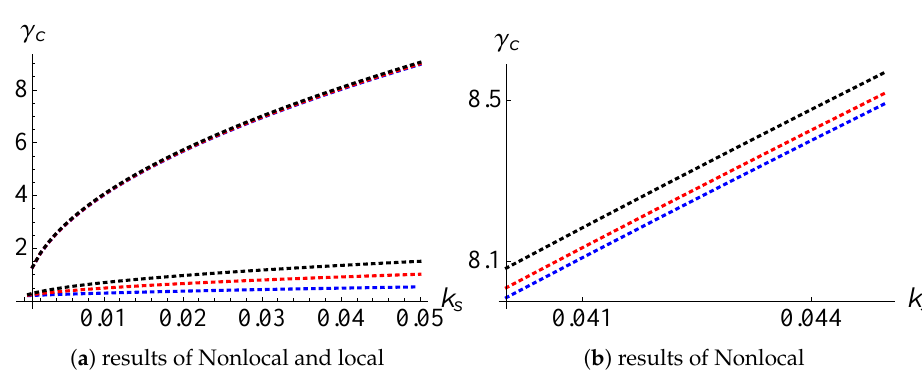
Figure 3. The critical velocity versus geometric parameter k s when p = 0.04, α = 40, ξ 1 = 0.5. Black dotted line, red dotted line and blue dotted line denote the results for k = 3,2,1 mode, respectively. In ( a ), the bottom of the three dotted lines denote the critical velocity of the classical results. ( b ) enlarger partial of full graph for nonlocal model.